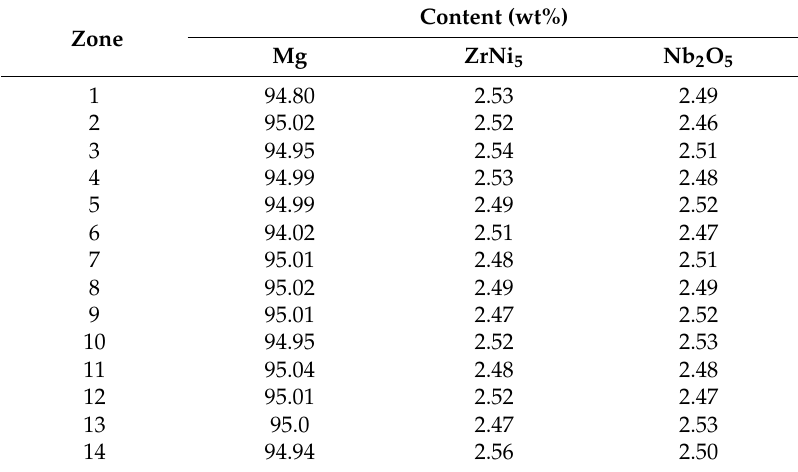
Table 1 lists the corresponding EDS results of elemental analysis for the selected zones shown in Figure 2. Based on the EDS analysis, it is concluded that the composition of the end-product for the nanocomposite powders that were obtained after this stage of milling is very homogeneous and does not seriously fluctuate in composition beyond the nanolevel, as shown in Table 1. Table 1. Elemental Analysis Corresponding to the Indexed Zones Shown in Figure 2. Content (wt%) Zone Mg ZrNi